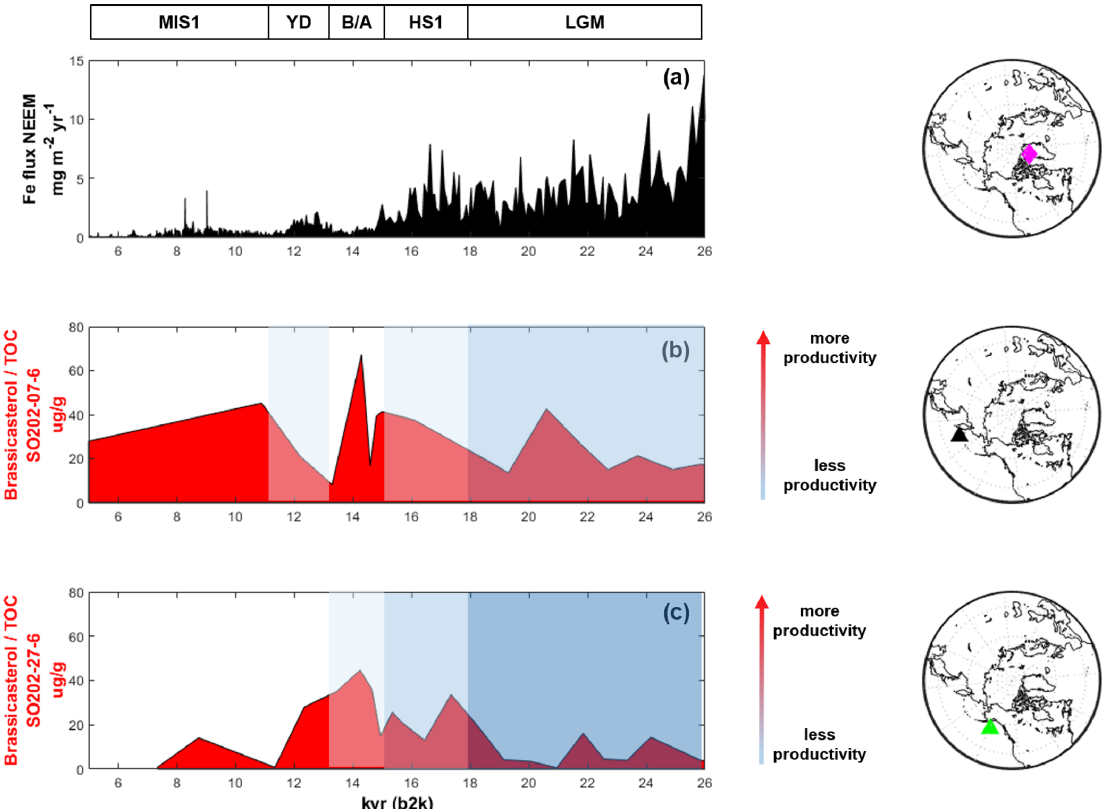
Figure 5. Relationship between the Fe flux in the NEEM core and MPP in subarctic Pacific Ocean over the last 26kyr, where a higher brassicasterol–total organic carbon ratio represents an increase in productivity. Sea ice data are from Meheust et al. (2018): prevalently extended sea ice (dark blue rectangle), prevalently marginal sea ice (blue rectangle), prevalently variable sea ice (light blue rectangle) and prevalently ice-free (white rectangle). The Fe flux record (black line, a ), productivity in the eastern subarctic Pacific Ocean (SO202-07-6, red line, b ) and productivity in the western subarctic Pacific Ocean (S0202-27-6, red line, c ) are also shown. Productivity pulses were recorded when sea ice changed its conditions towards ice-free conditions. YD stands for Younger Dryas, B/A stands for Bølling–Allerød, HS1 stands for Heinrich Stadial 1 and LGM stands for Last Glacial